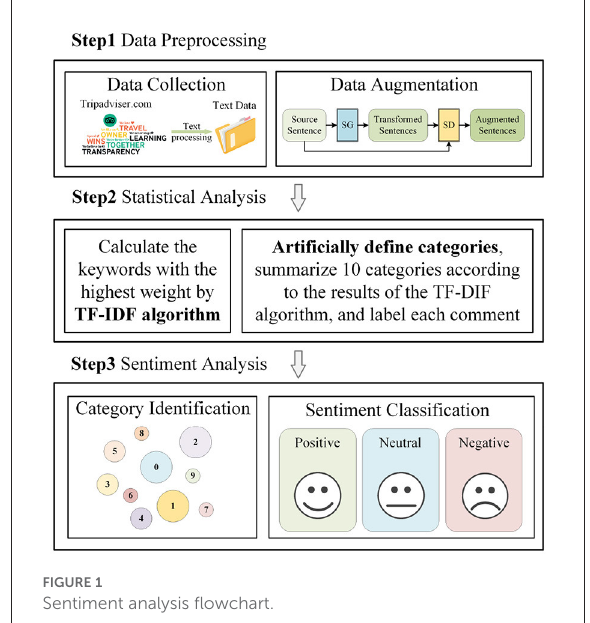
FIGURE1 Sentiment analysis